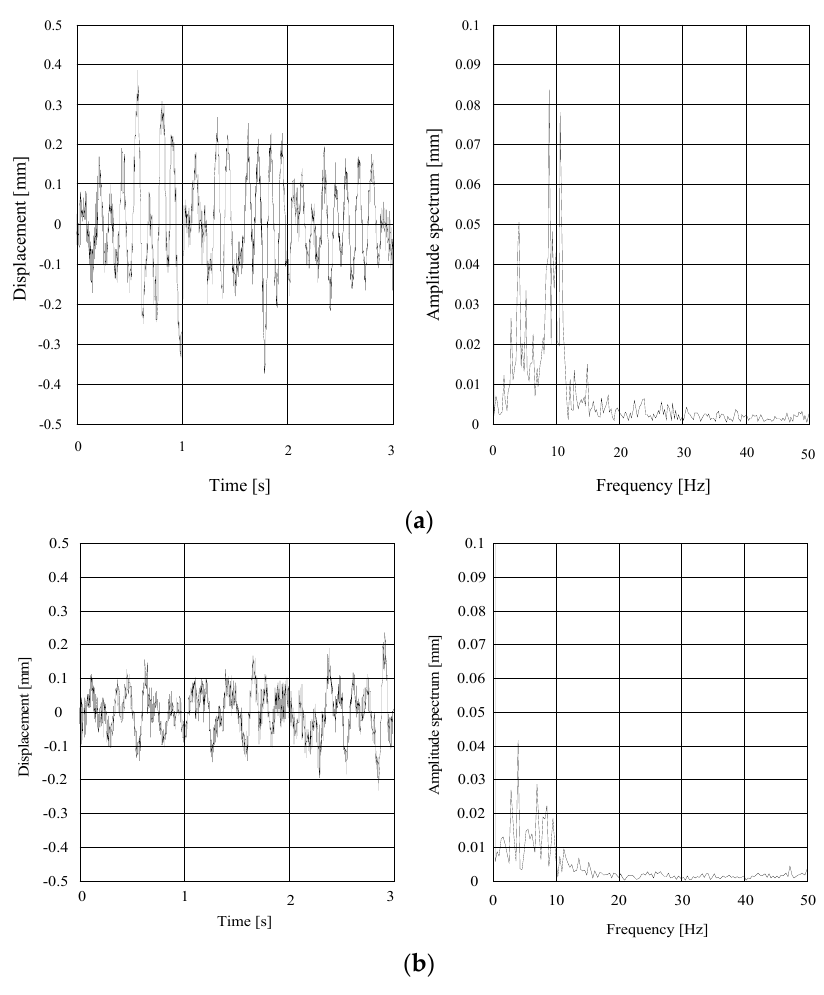
Figure 9. Bending levitation result when vibrating frames by the random disturbance ( θ = 13°). ( a ) Optimal control; ( b ) Optimal control with disturbance cancellation control. Table 5. Standard deviation of